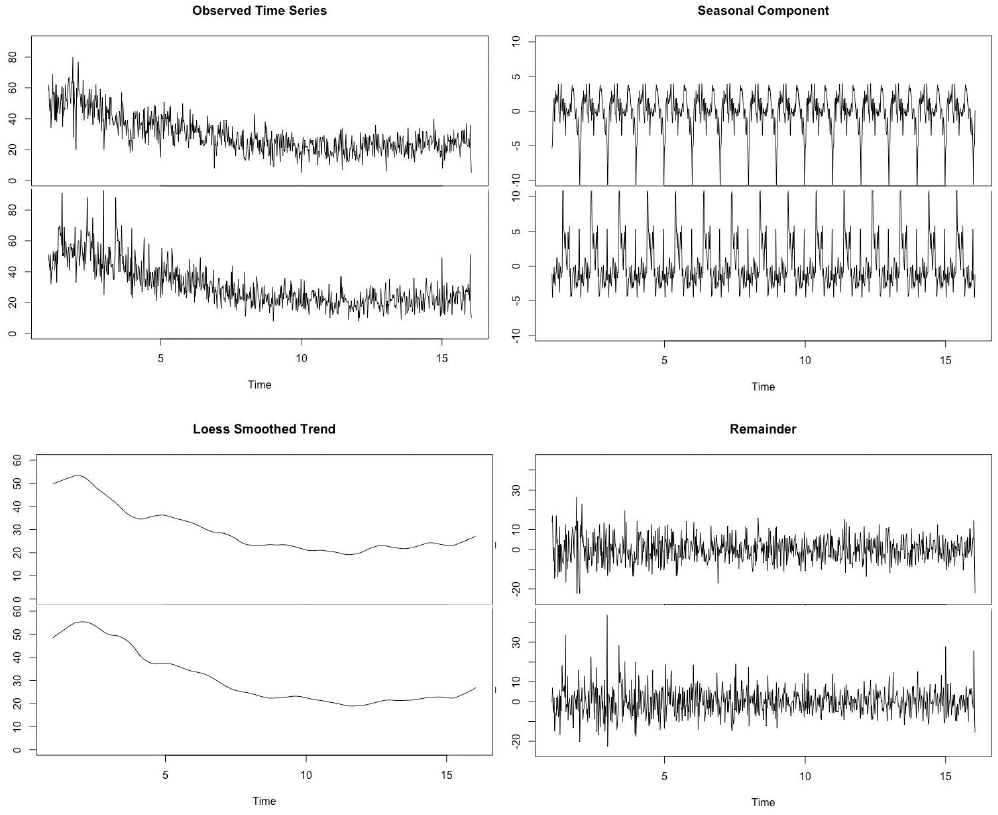
Figure 1. Weekly congregate care admissions (upper panels) and discharges (lower panels) in four components. Upper left—The observed raw admission (top) and discharge (bottom) data. Upper right—The seasonal patterning of those series in an annual period, with admissions on the top and discharges on the bottom. Lower left—The loess smoothed trend series after extracting the seasonal component. Lower right—The unexplained remaining variance in the observed series after considering the seasonal and trend components.